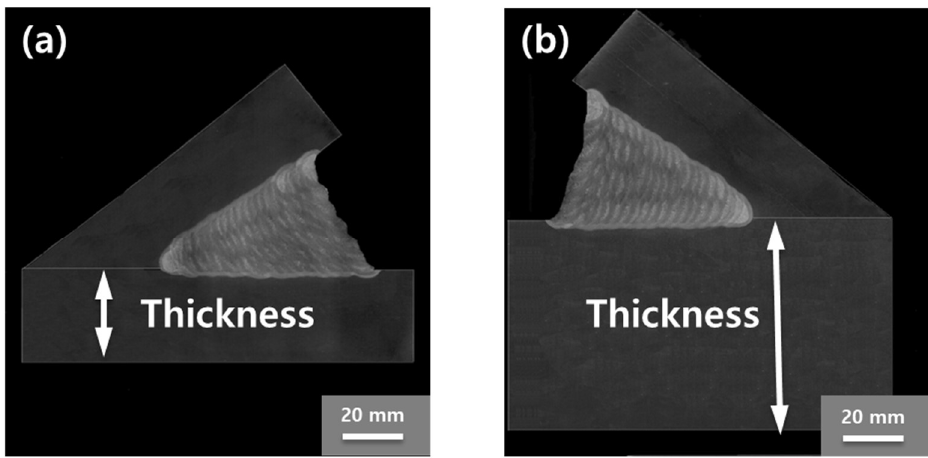
Figure 13. Cranfield test results: ( a ) the 30 mm thick plate; ( b ) the 70 mm thick plate.